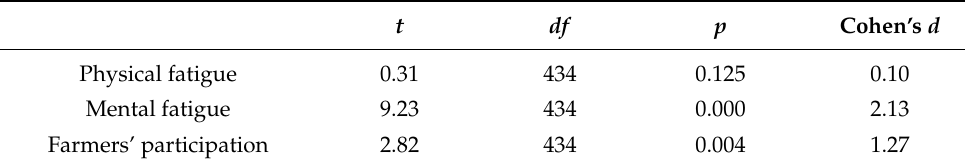
Table 5. Test of differences.